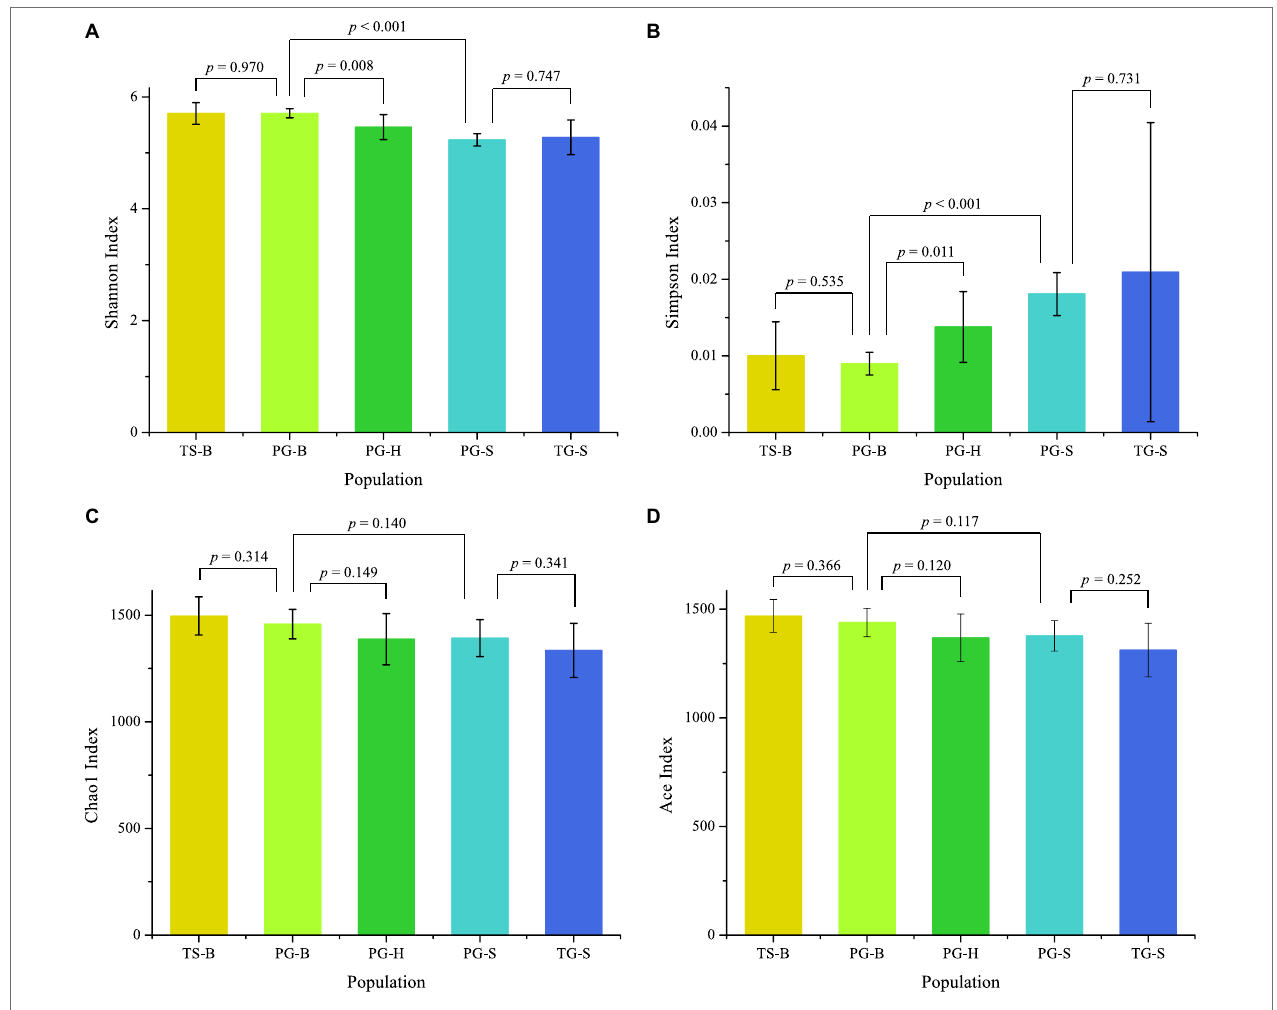
FIGURE 4 | Comparison of alpha diversity of the gut bacterial community among the five populations. TS-B (yellow), Tibetan sheep on Bird Island; PG-B (lime), Przewalski’s gazelle on Bird Island; PG-H (green), Przewalski’s gazelle in Haergai; PG-S (mint), Przewalski’s gazelle in Shengge Township; and TG-S (blue), Tibetan gazelle in Shengge Township. Diversity (A,B) was significantly higher in managed PG-B than in wild PG-H and PG-S, but richness (C,D) was not different. No differences were found between sympatric PG-B and TS-B, and between sympatric PG-S and